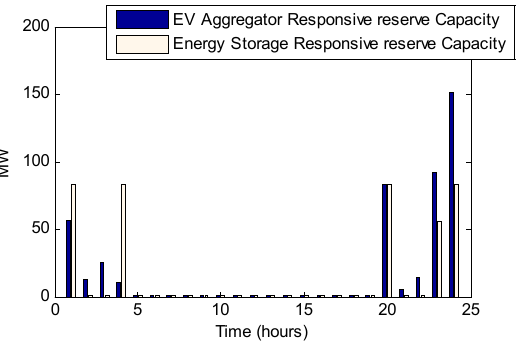
Figure 9. Regulation up capacity of the EV aggregator and dedicated storage unit.